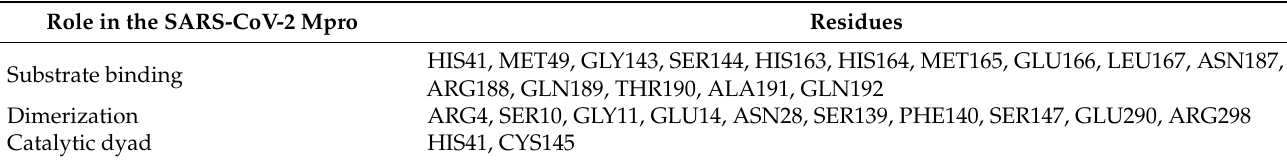
Table 11. List of key residues of SARS-CoV-2